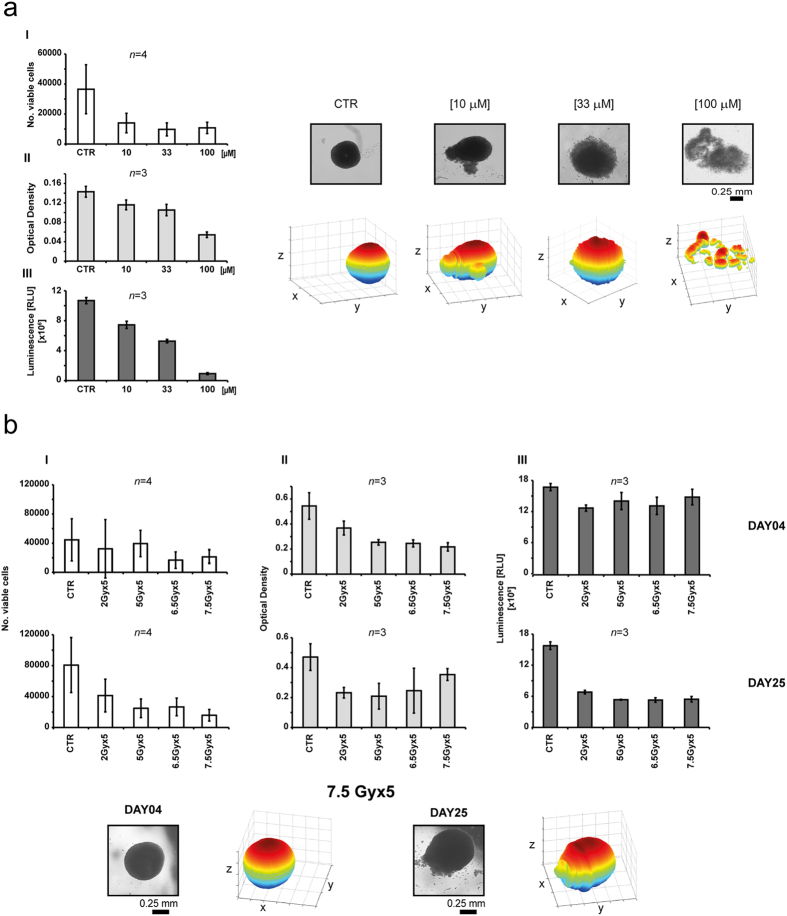
Evaluation of cell viability assay in tumor spheroid models.(a) Homogeneous-sized and -shaped A549 spheroids were treated for 72 h with three concentrations (10, 33 and 100 μM) of 4-HPR-HSA and viability was evaluated using 3 different assays: Trypan blue exclusion test, data are the mean of four repetitions, n = 4 (I), Perfecta3D-Cell Viability Assay, n = 3 (II), and CellTiter-Glo®3D Cell Viability assay, n = 3 (III). Brightfield imaging of untreated spheroids (control, CTR) and spheroids treated with increasing doses of 4-HPR-HSA (left to right) was acquired after a 72-h treatment; Scale bar= 0.25 mm. The corresponding 3D reconstructions were obtained by using ReViSP, http://sourceforge.net/p/revisp/. (b) Homogeneous-sized and -shaped A549 spheroids were exposed to four different radiation schedules (2 Gy × 5, 5 Gy × 5, 6.5 Gy × 5 and 7.5 Gy × 5 days). Cell viability was evaluated 4 and 25 days after the end of radiation treatment. Brightfield images of spheroids treated with 7.5Gy × 5 days were taken 4 and 25 days after the end of radiation treatment. Scale bar = 0.25 mm.